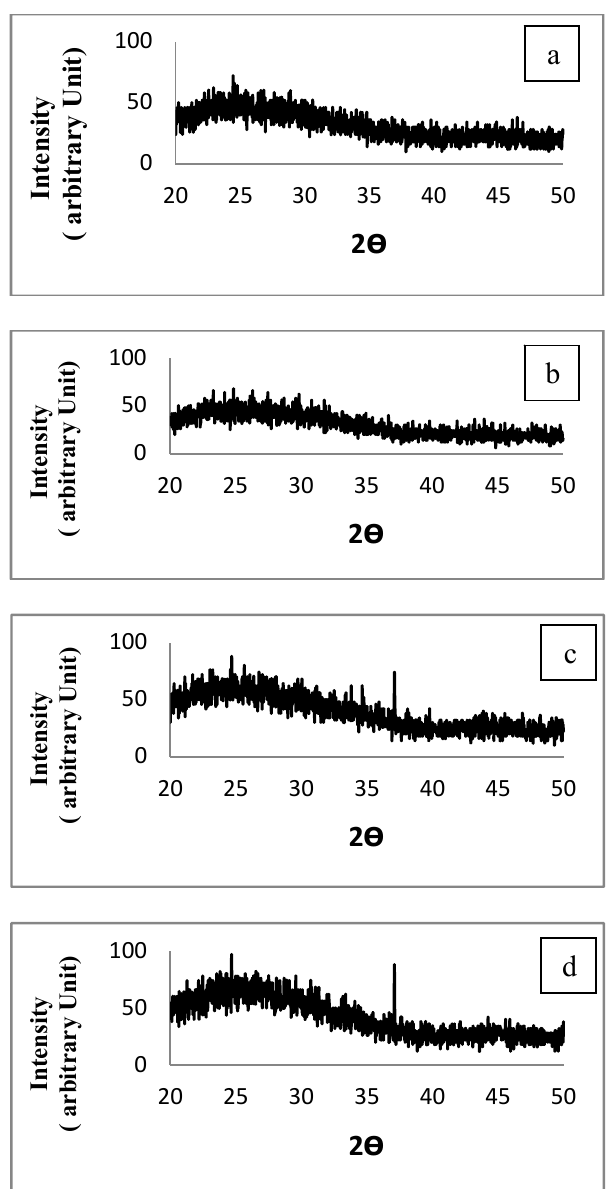
Fig. 1: XRD pattern of NiO (a):as deposited(303K) (b):T =RT (c):T